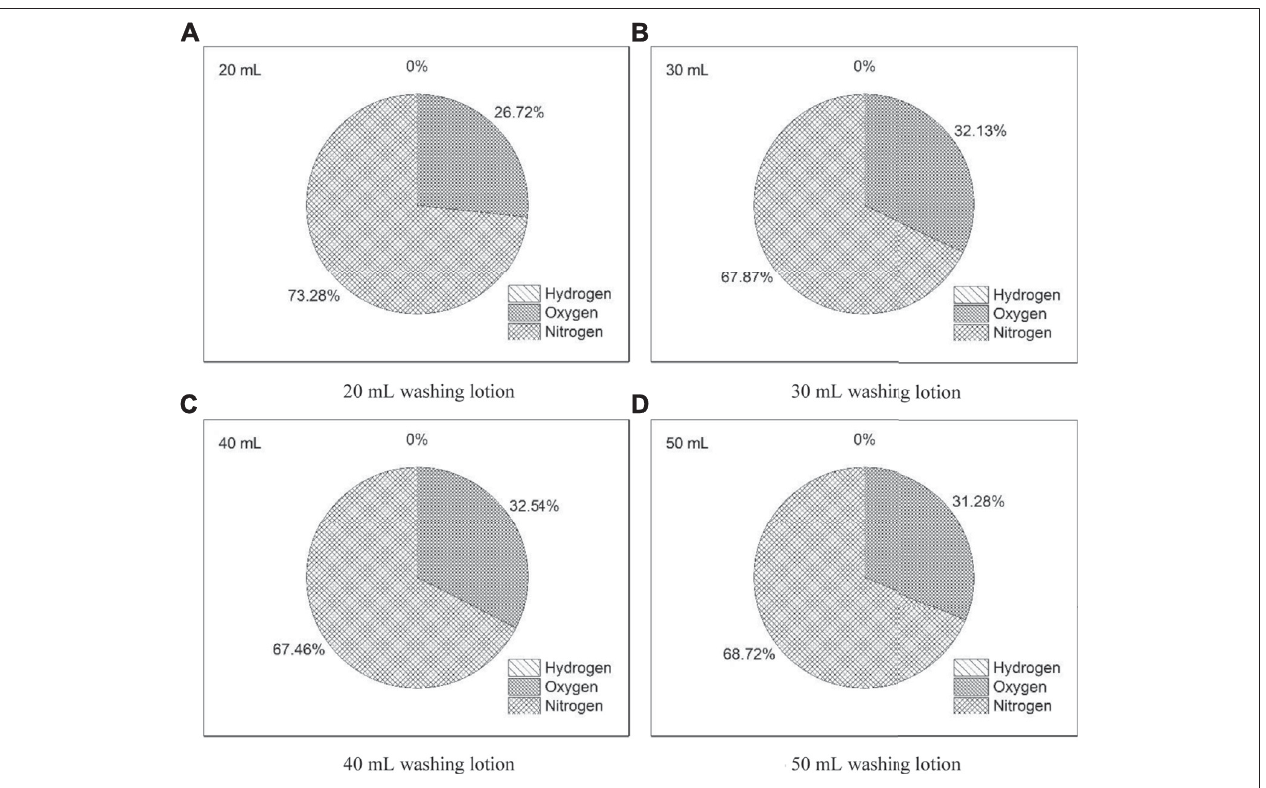
FIGURE 6 | Composition of the gas products with different washing lotion volume: (A) 20ml, (B) 30ml, (C) 40ml, and (D) 50 ml.